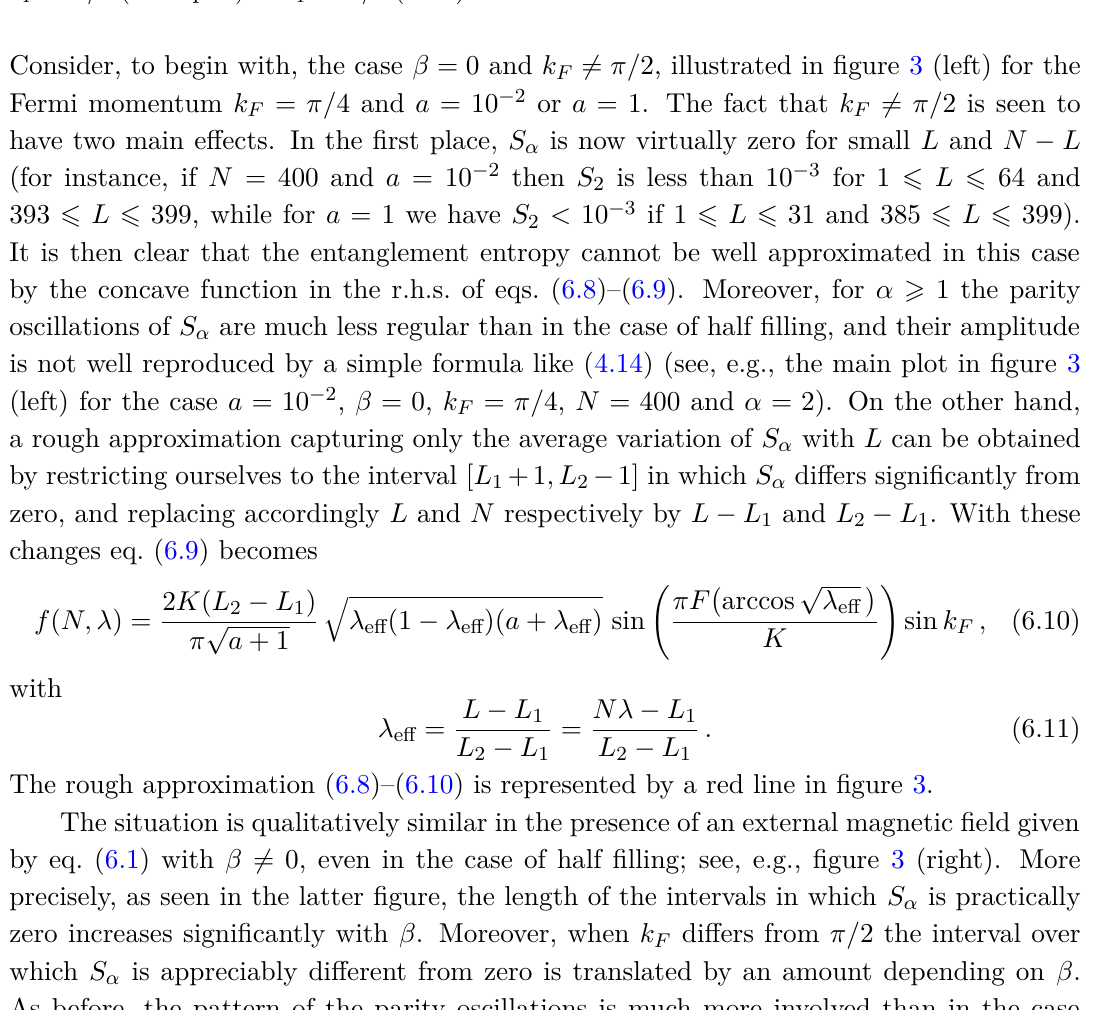
Figure 3 . Left: Rényi entanglement entropy S 2 for the sextic chain with N = 400 spins, a = 10 − 2 , β = 0 , and k F = π/ 4 (blue crosses) compared to its rough approximation (6.8)–(6.10) (solid red line). The inset shows the same plot for a = 1 . Right: analogous plot for a = 10 − 2 , β = 5 and k F = π/ 4 (main plot) or k F = π/ 2